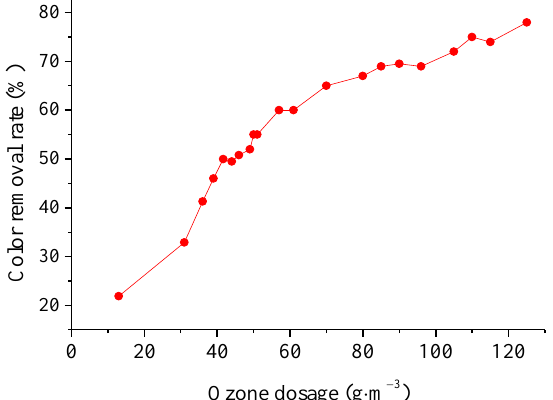
Figure 3. Effect of ozone dosage on the color removal rate (initial color at 125 times) .